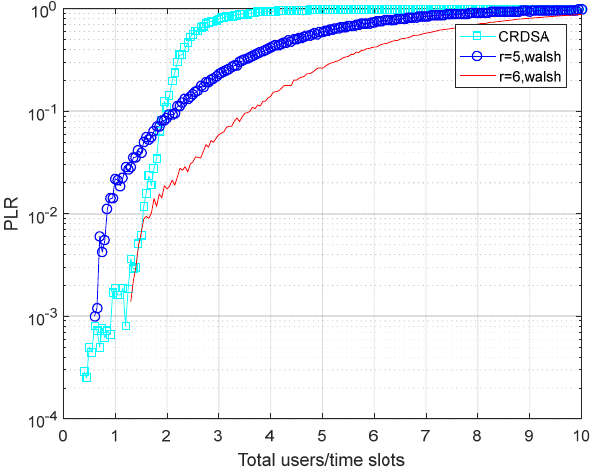
Figure 10. Comparison curve of PLR under the same number of time slots.